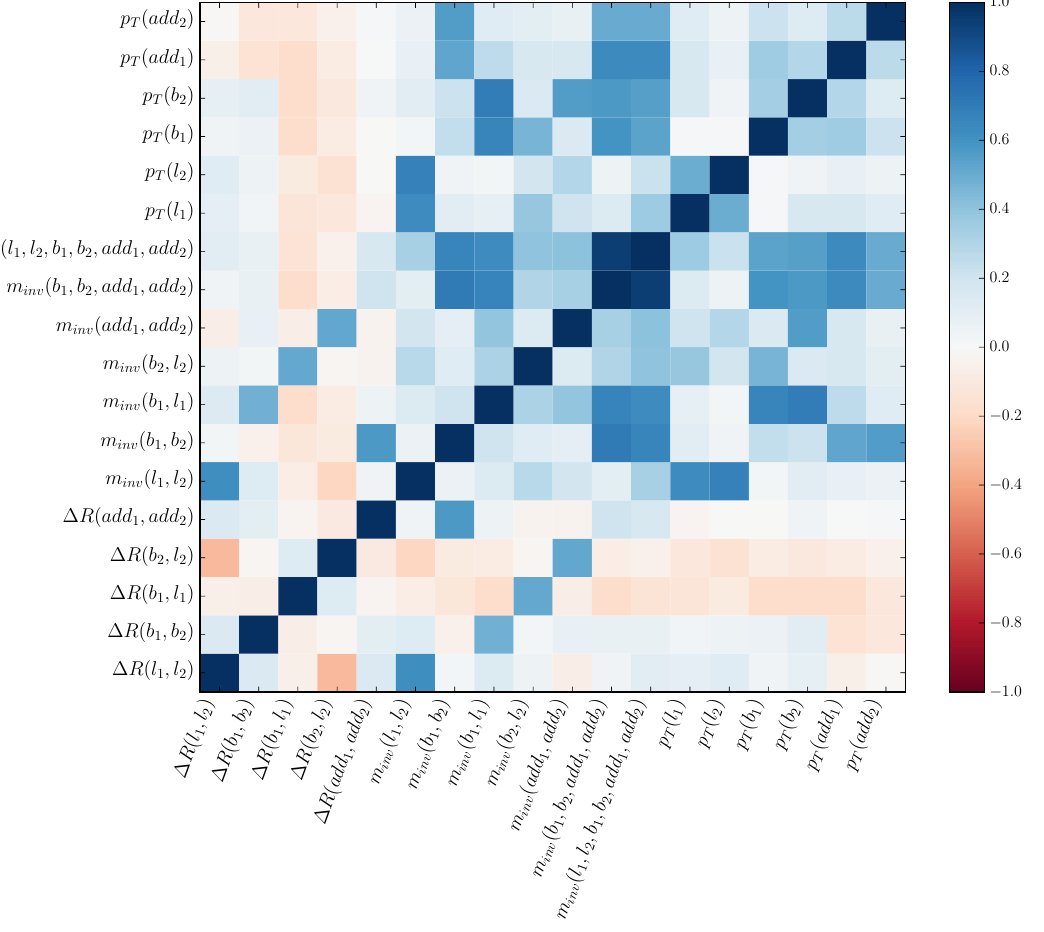
Figure 19 . Correlation matrix of the NN input